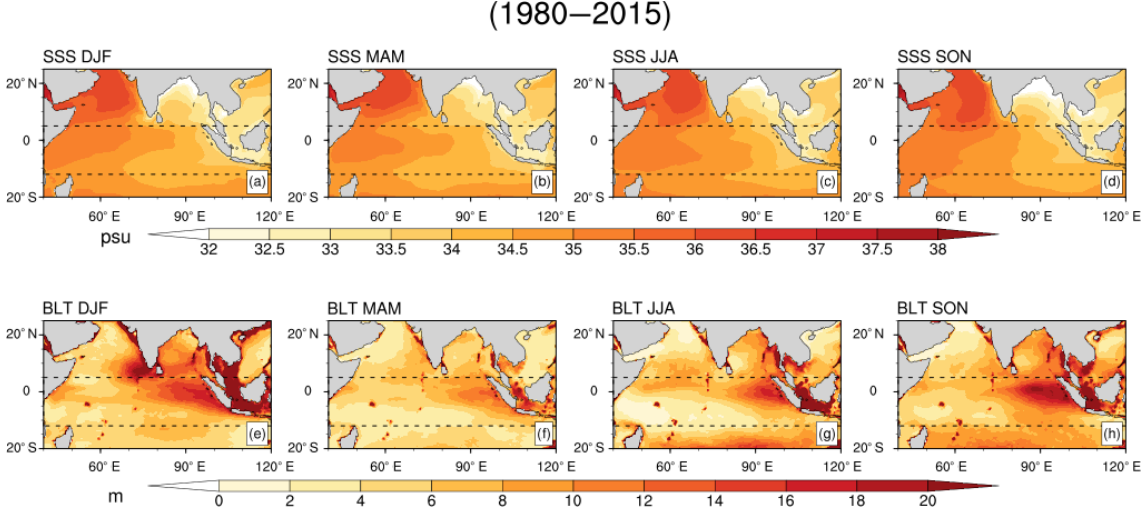
Figure 5. The seasonal distributions of SSS (unit: psu; a–d ) and BLT (unit: m; e–h ) in the Indian Ocean from 1980 to 2015. The two dashed black lines represent the latitudes of 12 ◦ S and 5 ◦ N, respectively.